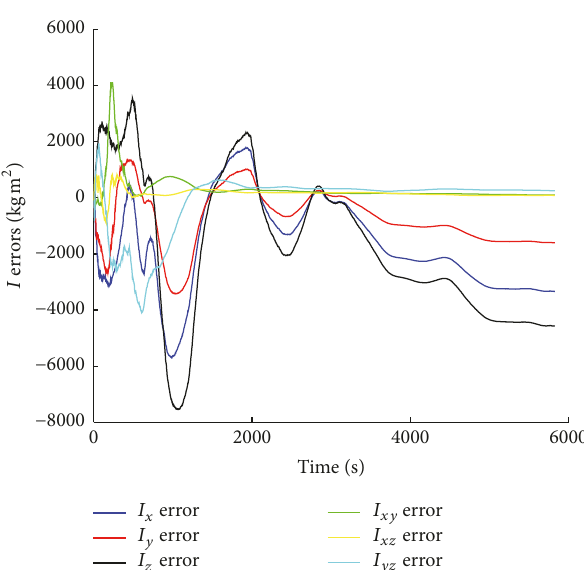
Figure 10: Errors in estimating the elements of the inertia matrix.